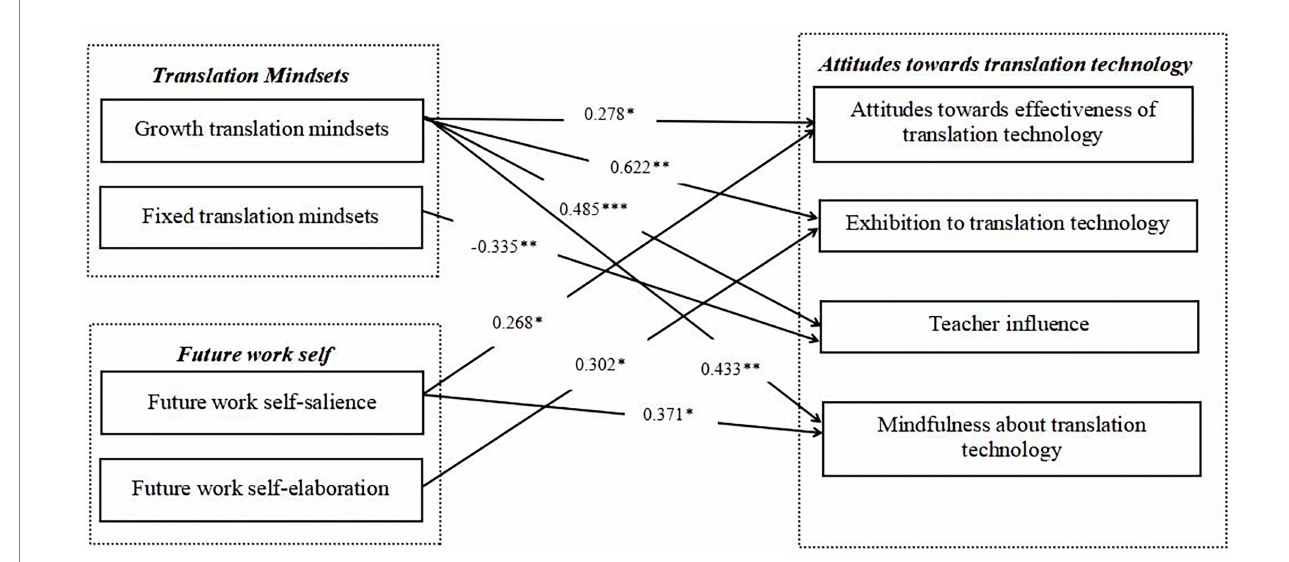
FIGURE 3 The modified structural model for relations between students’ TM, FWS and